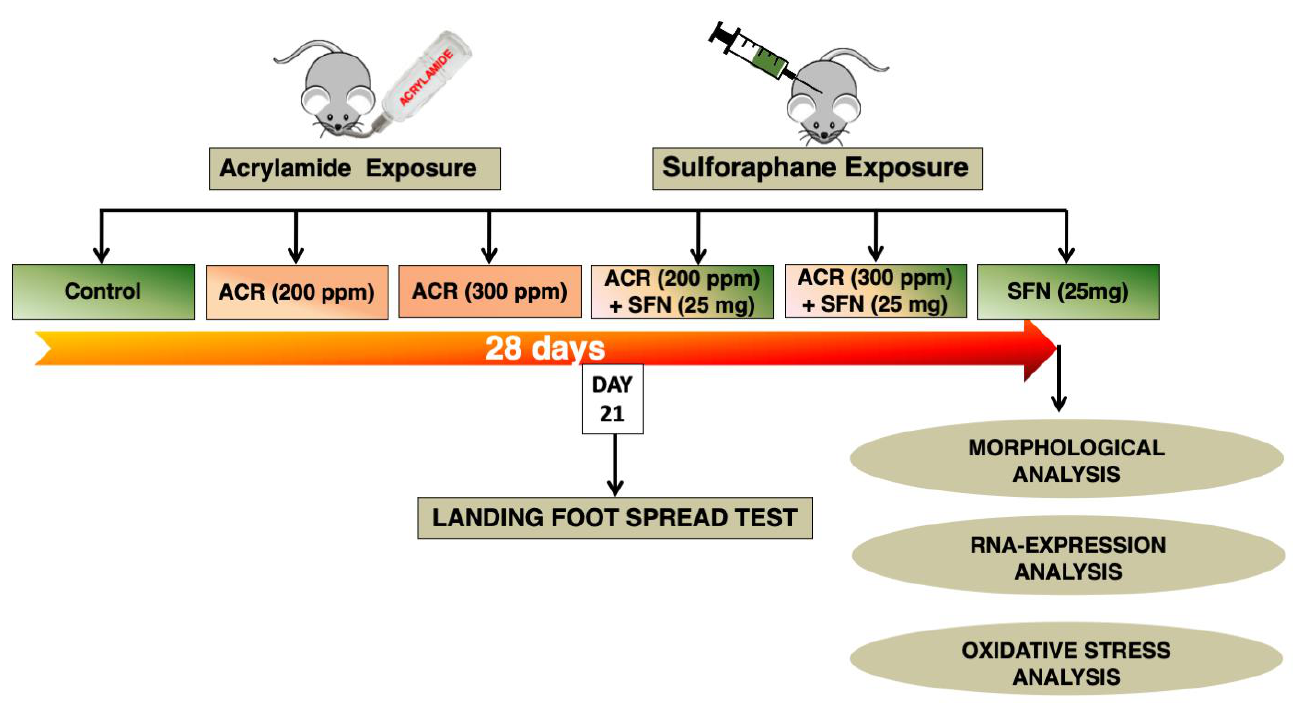
Figure 8. Schematic illustration of the study design. Drinking water containing acrylamide was provided daily to wild- type mice for four weeks. Each mouse also received injection of sulforaphane or saline daily for four weeks. The mice underwent functional tests (landing foot spread test) after 21 days of exposure, morphological analysis (immunostaining of neurotransmitter-specific-reactive axons; hematoxylin and eosin staining of liver), RNA-expression analysis and oxidative stress analysis after the 4-week exposure.